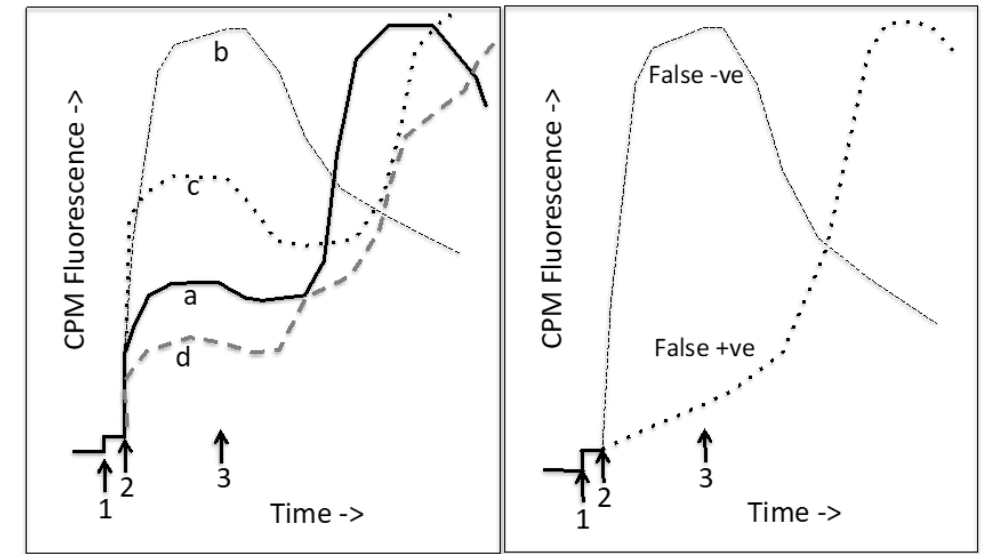
Figure 6. Thermostability assay. CPM labeling experiments: CPM is added to the cuvette (1) at low temperature (e.g., 10 °C) and then the protein is added (2). After a period of labeling of surface exposed Cys residues, the cuvette is heated (starting at 3). Initially the CPM fluorescence decreases due to thermal quenching, but then as the protein unfolds, the CPM fluorescence rises, reaching a maximum after the protein is completely unfolded. After this, thermal quenching of the CPM fluorescence is again observed. Left panel shows typical CPM unfolding profiles for different membrane proteins. Trace a (the solid line) is for a membrane protein such as CFTR with about 40% of its 18 Cys residues exposed to the aqueous medium. It shows a single cooperative unfolding transition. Trace b (black, dashed) is for an unusual (perhaps very small) membrane protein with no buried Cys residues. Trace c (black, dotted) is for a very thermophilic membrane protein but with mostly exposed Cys residues. Trace d is for a membrane protein with few exposed Cys residues in the native state. It has multiple domains that show separate unfolding transitions. The right panel illustrates potential false results when examining the effects of drugs. A false negative drug (false destabilizer) will have a CPM-reactive group that reacts rapidly with CPM at low temperature. A false positive drug (apparent corrector) will have a CPM-reactive group that labels slowly at low temperature and then the rate of reaction speeds up upon heating.